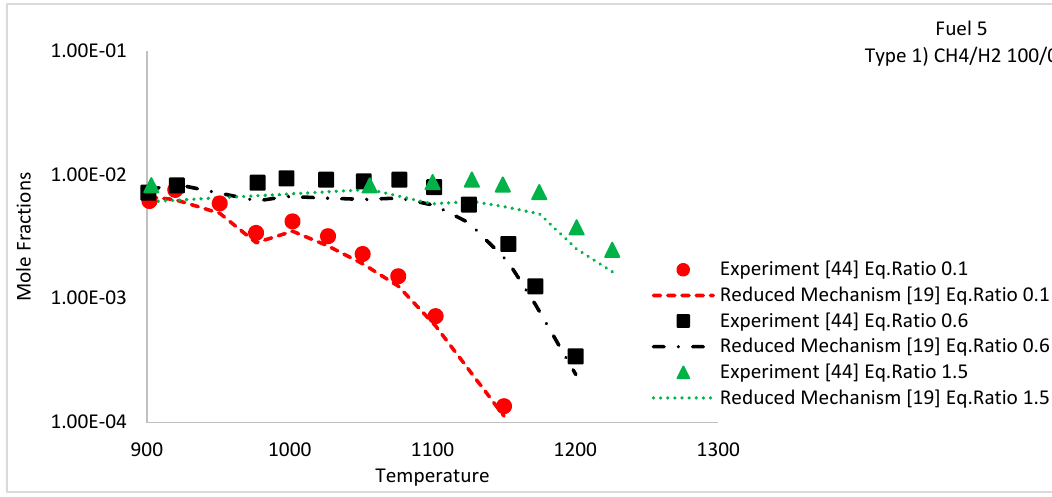
Figure 8. Comparison of the calculated CH 4 profiles by using the reduced mechanism [19] and the experimental measurements from Reference [44] for 100% methane mixture at pressure 10 bar, temperatures 900–1450 K and eq.ratios 0.1, 0.6 and 1.5.